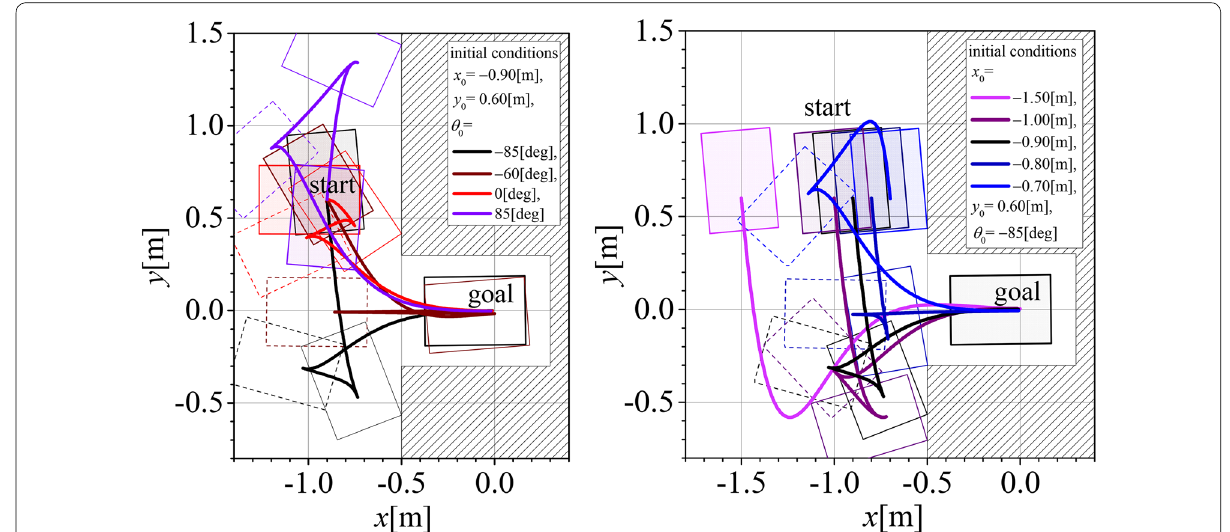
Fig. 16 Simulation results using α 1 , α 2 and X s searched, respectively for various initial